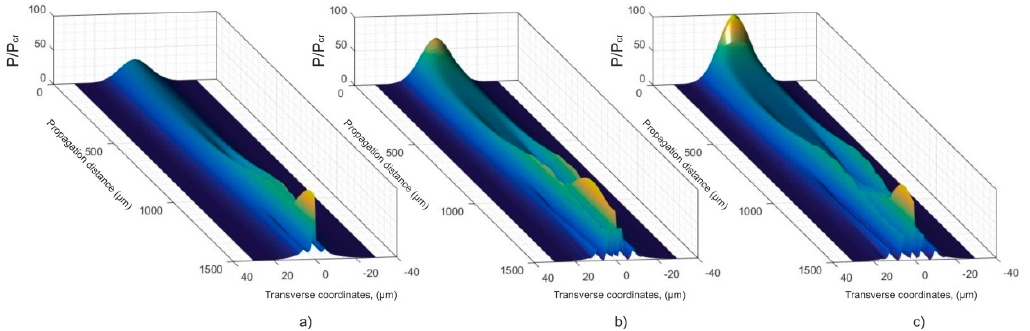
Figure 10. Beam intensity distribution dynamics vs. propagation distance in water when the initial energy of the beam is expressed as the ratio P/P CR . ( a ): 33 P/P CR , ( b ): 66 P/P CR , ( c ): 100 P/P CR . The point 0 µm corresponds to the air-water interface.